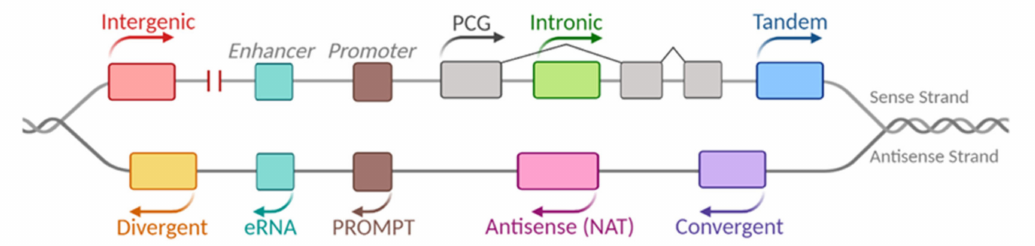
Figure 1. Long non-coding RNA (LncRNA) classification according to their genomic context relative to protein-coding genes (PCGs) and their regulatory DNA elements. See text for